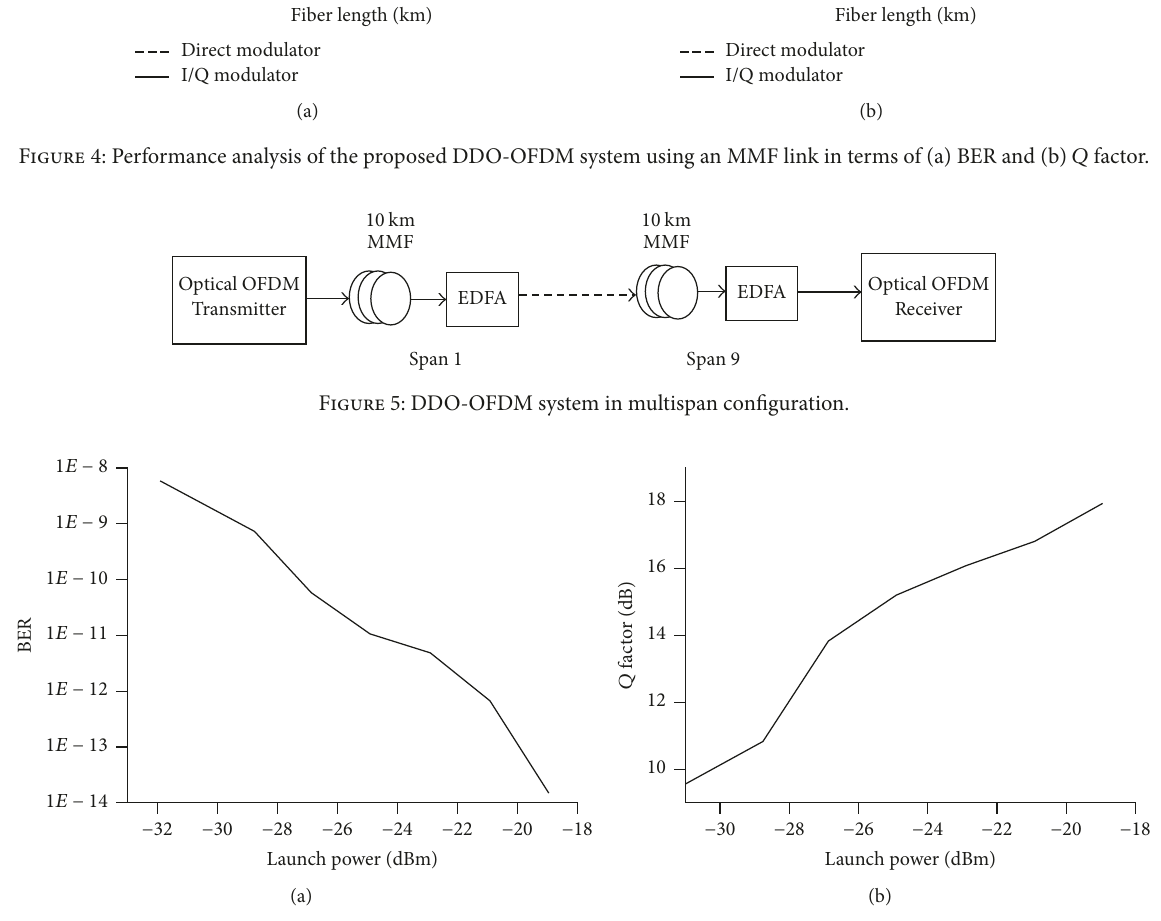
Figure 6: Performance analysis of the proposed DDO-OFDM system with respect to the launch power in terms of (a) BER and (b) 𝑄 factor.